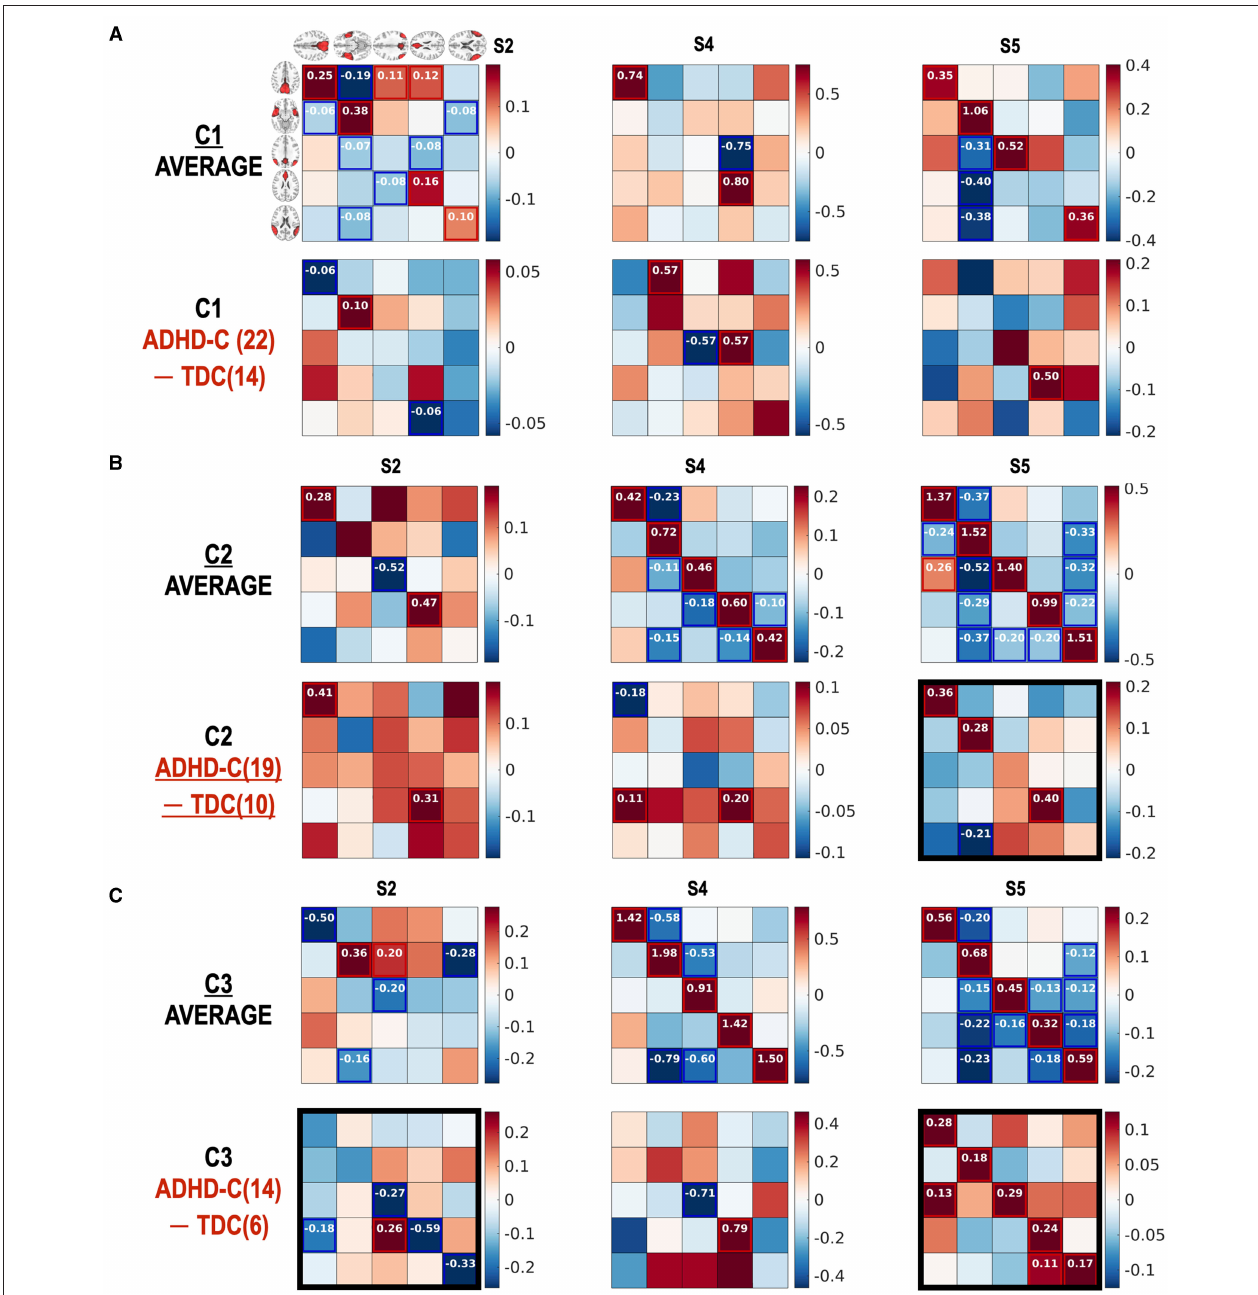
FIGURE 8 | (Diagnostic) group comparison results for individuals in the same subtype according to the state occupation patterns. The group comparison results between ADHD-C and TDC according to subtype C1 (A) , subtype C2 (B) , and subtype C3 (C) are presented. Number in () indicates the number of subjects. We found significant (diagnostic) group differences in the effective connectivity at the functional connectivity states S2 and S5, particularly in the subtype group C3. Subtype-specific group differences between ADHD-C and TDC were detected. The diagonal term should be understood after a transformation of − 0.5exp(A ii ), indicating more self-inhibition for higher values of diagonal terms. The black rectangles show prominent group differences.